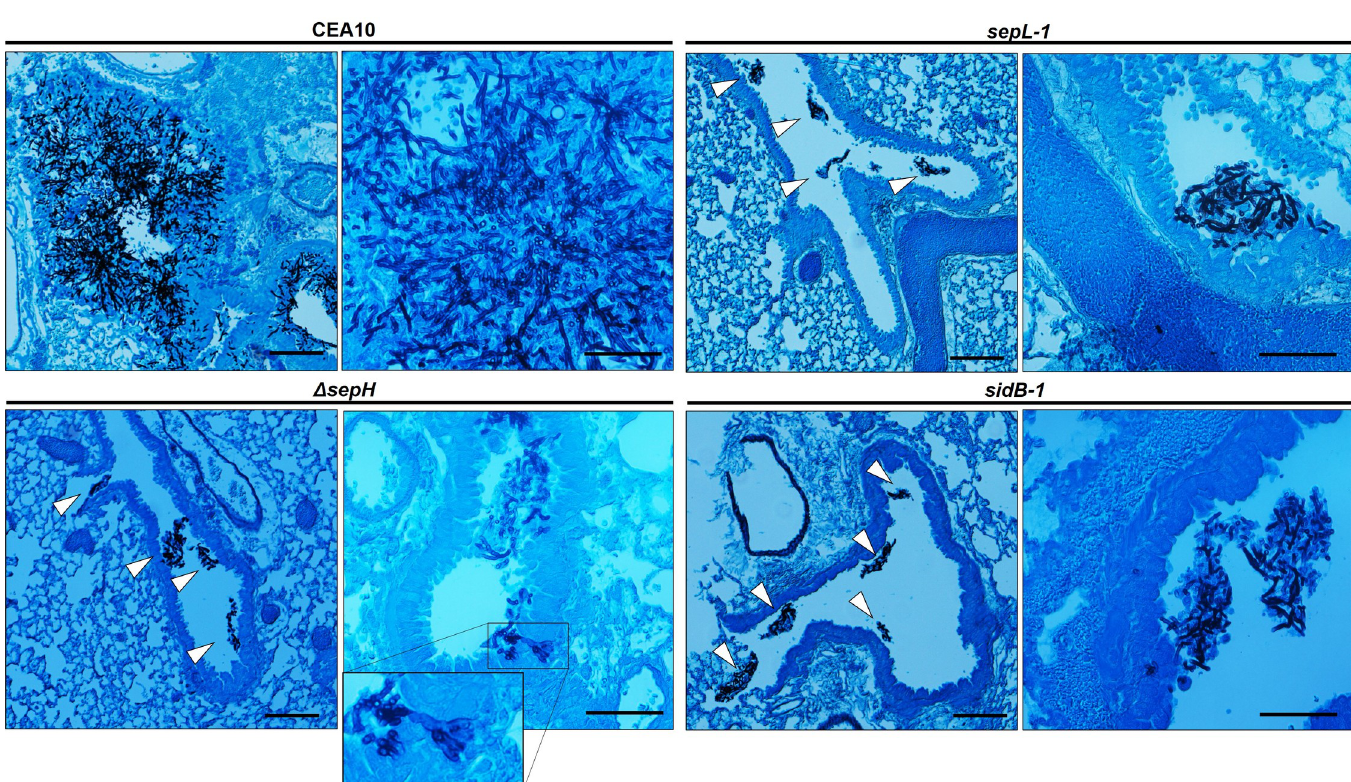
Fig 8. Loss of virulence among the SIN kinase mutants is associated with lack of tissue invasion. Low- and high-magnification photomicrographs of Gomori methenamine silver (GMS)-stained lung tissue sections from the CEA10, Δ sepH , sepL-1 and sidB-1 at day +4 post-inoculation. Mice were immune suppressed with triamcinolone acetonide and inoculated with each strain as described for the previous survival studies. Hyphae (black stained fungal elements) from the CEA10 strain were noted to invade lung tissue, forming fulminant lesions. In contrast, growth of each SIN kinase mutant was limited to the airways with minimal to no tissue invasion (white arrowheads). Rare tissue invasion was associated with loss of polarity maintenance ( Δ sepH inset panel). Scale bar = 50 μ